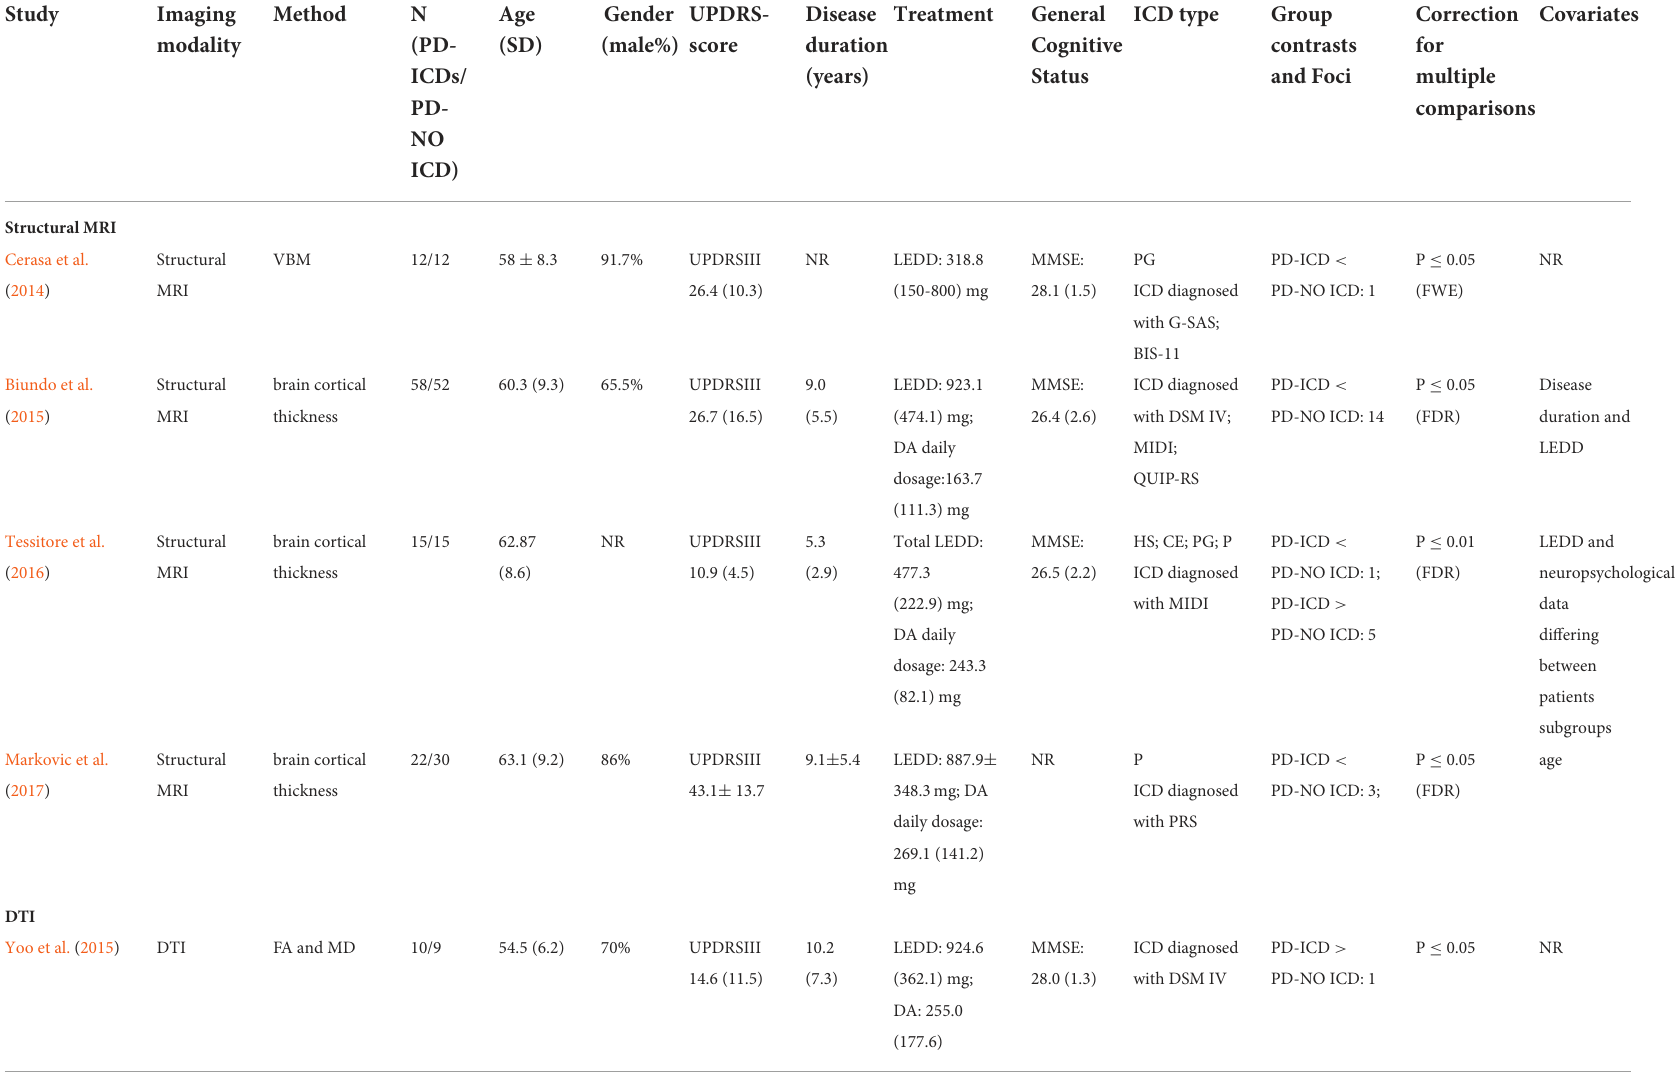
TABLE 1 Characteristics of fMRI